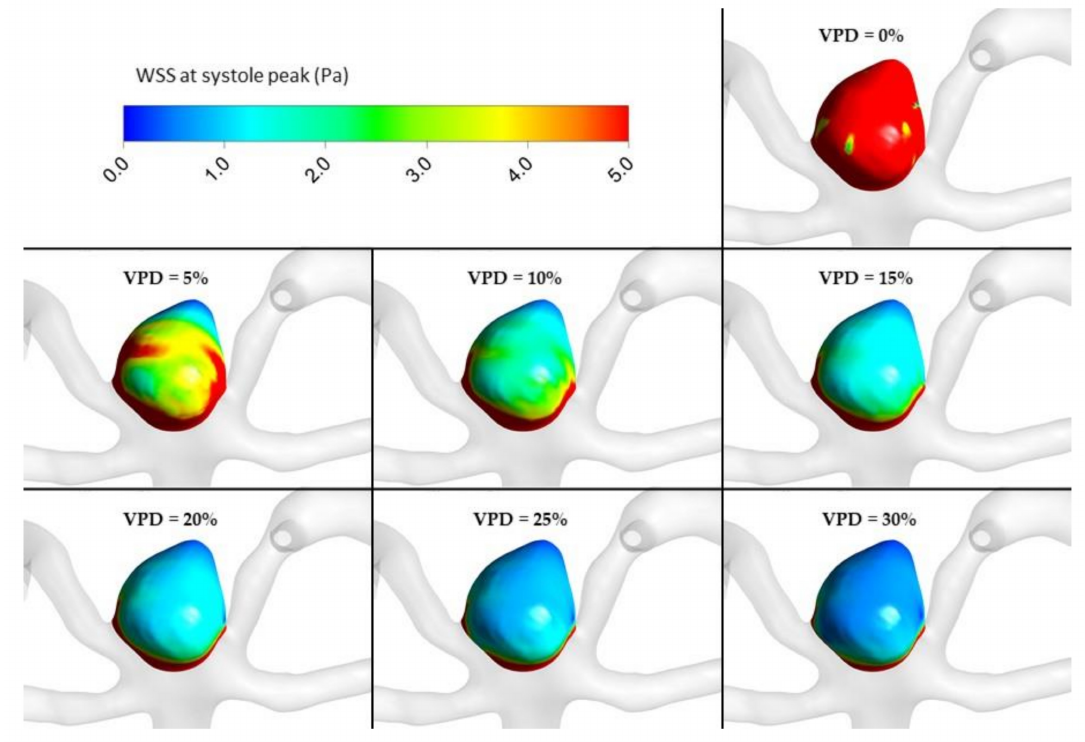
Figure 17. WSS distribution at aneurysm wall for selected VPD cases; transient simulations—systole